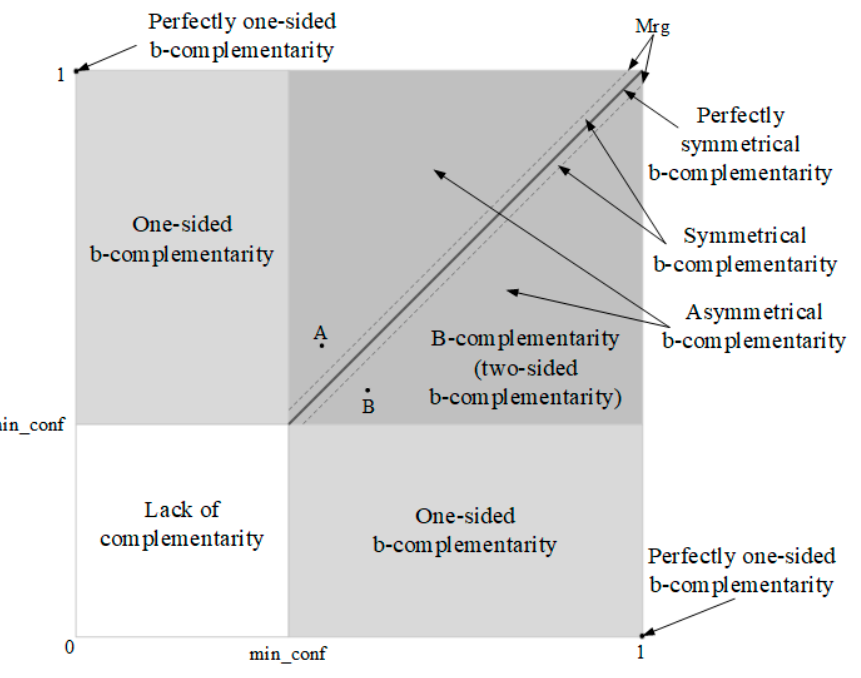
Figure 1. Types of b -complementarity for any pair of goods.